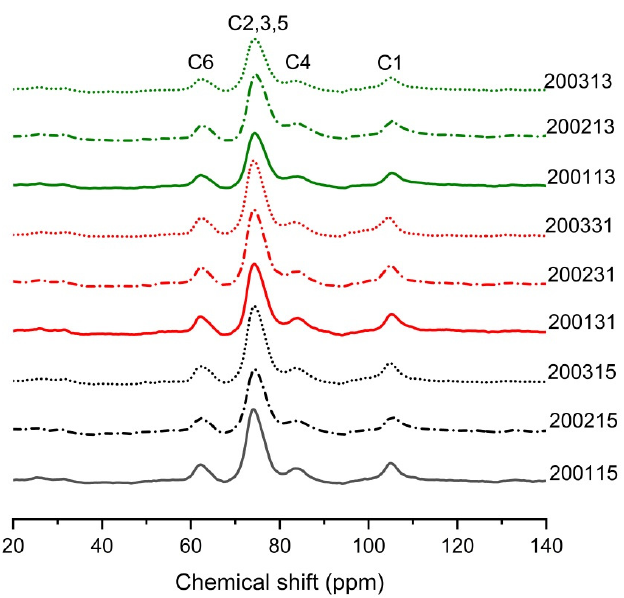
Figure 5. The 13 C solid state NMR spectra of different recombinant flours. Table 6. The molecular order of starch by 13 C solid-state